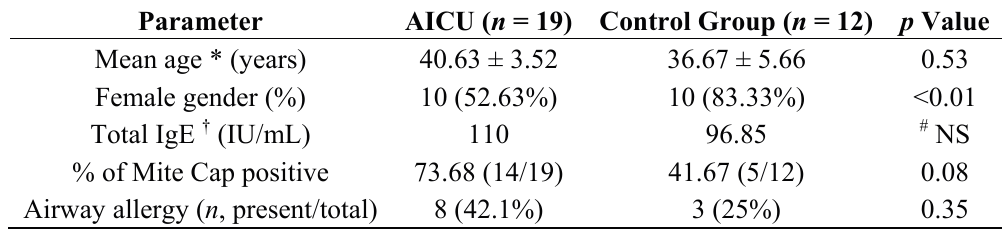
Table 1. Disease characteristics of the subjects with aspirin-induced chronic urticaria (AICU) and control group with those not allergic to